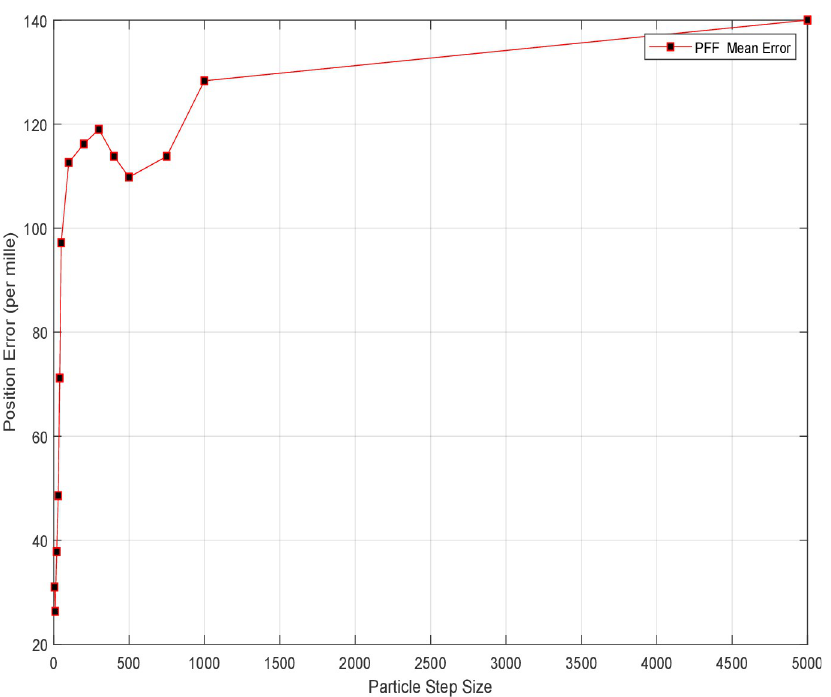
Fig 15. PFF-A-SLAM algorithm estimation error versus step size.